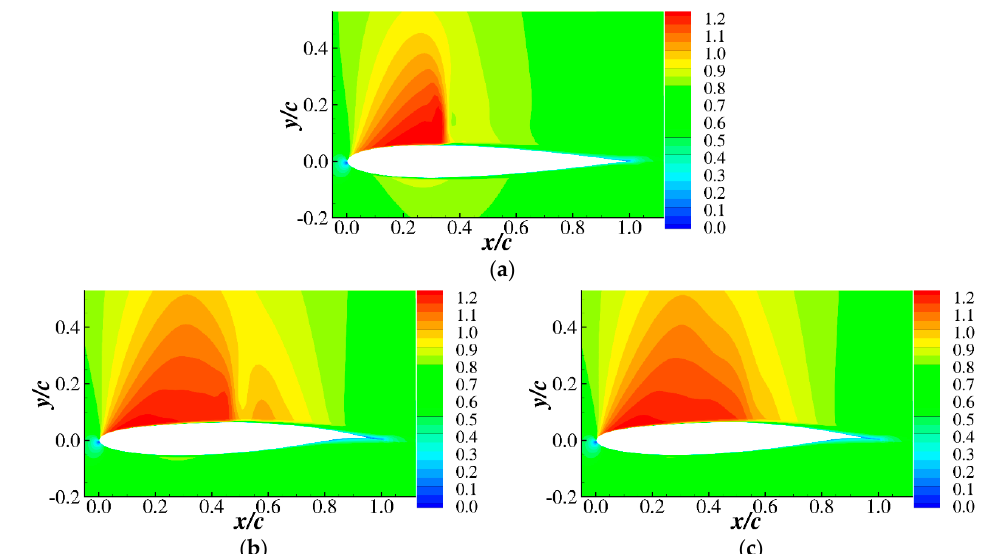
Figure 7. Mach number contours of the initial airfoil and the optimized airfoils. ( a ) Initial airfoil; ( b ) optimized airfoil with ω = 0.002; and ( c ) optimized airfoil with ω = 0.001.